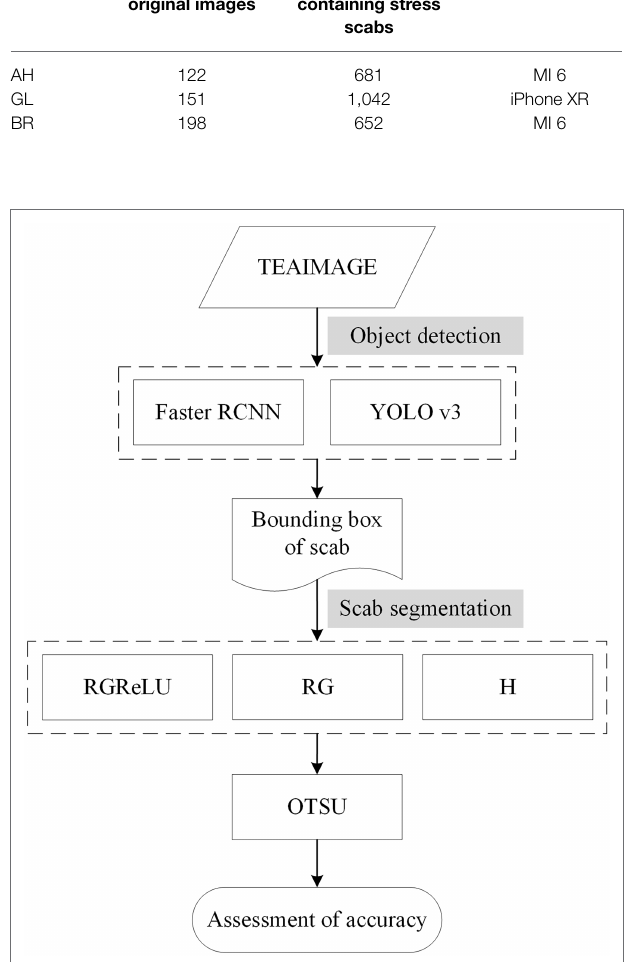
FIGURE 2 | The workflow of the proposed method for detecting tea plant stresses at canopy